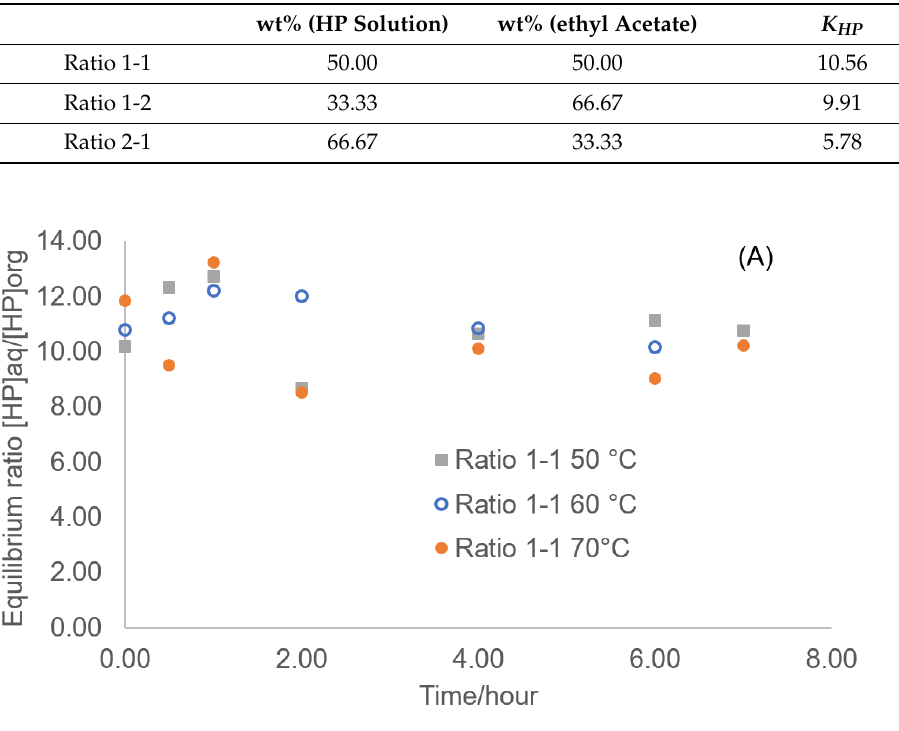
Table 3. Liquid-liquid ratio and calculated values of K HP .